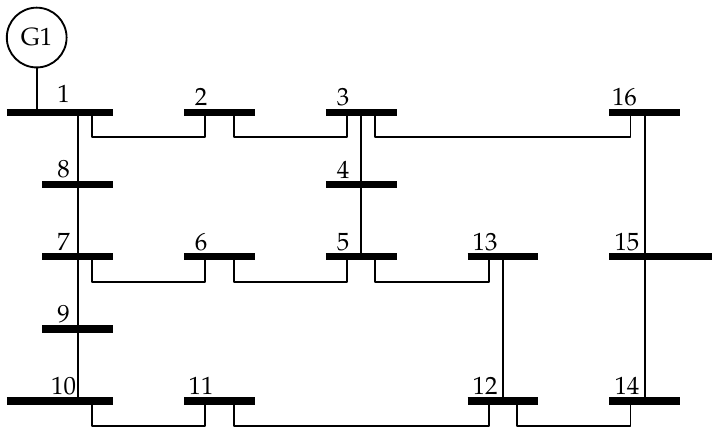
Figure 6. Diagram of the system used in tests. Node 1 is a slack bus.